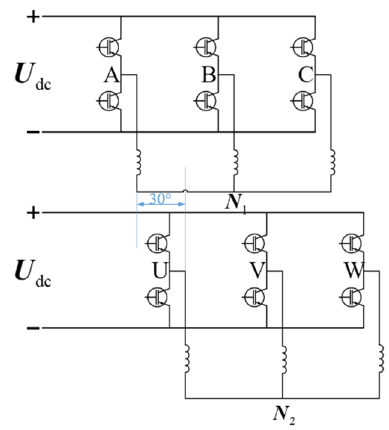
Figure 2. Dual three-phase motor system powered by dual voltage source inverters.